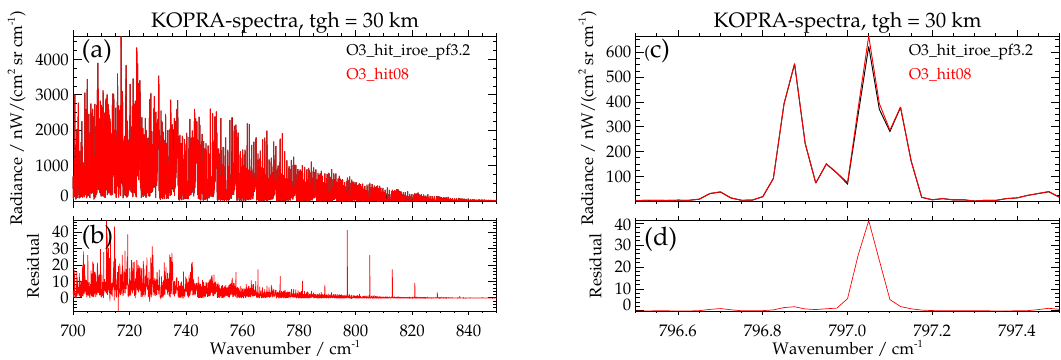
Figure 12. (a) Modelled ozone spectra for a tangent height of 30km using the MIPAS-pf3.2 (black) and HITRAN-2008 spectroscopy (red). (b) Difference between the two simulations. (c, d) Same as on the left but for a close-up of the spectral region around 797.0cm − 1 .